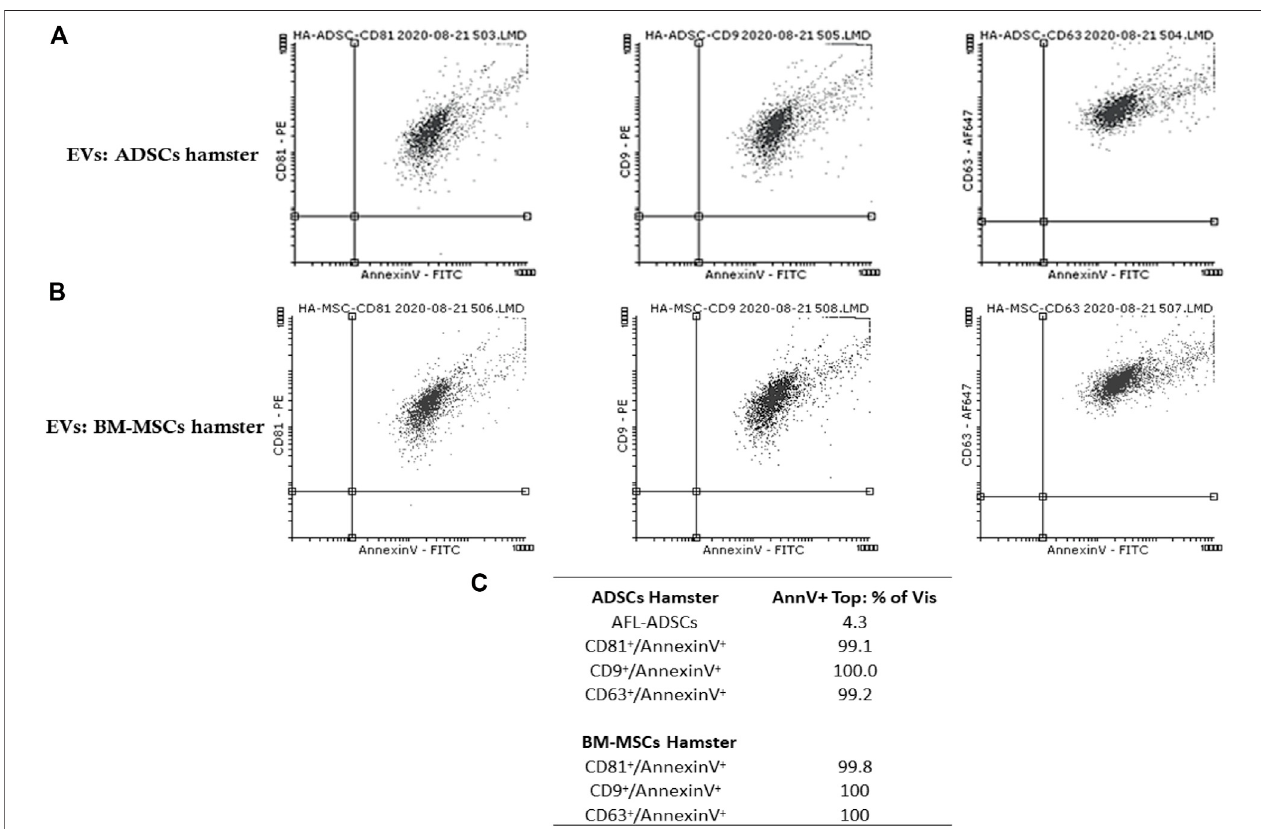
FIGURE 3 | Detection and characterization by fl ow cytometry of EVs isolated from the culture medium from ADSCs/BM-MSCs of healthy hamsters highlight the presence of both exosomes (CD63 + , CD9 + , and CD81 + ) and microvesicles (AnnexinV + ). (A) Representative dot plots double-stained with puri fi ed EVs from ADSC fractionwithCD81 + (labeledwithPE)/AnnexinV + (labeledwithFITC), CD9 + (labeledwithPE)/AnnexinV + (labeledwithFITC),and CD63 + (labeledwithAF647)/Annexin V + (labeled with FITC); (B) representative dot plots double-stained with puri fi ed EVs from the BM-MSC fraction with CD81 + (labeled with PE)/Annexin V + (labeled with FITC), CD9 + (labeled with PE)/Annexin V + (labeled with FITC), and CD63 + (labeled with AF647)/Annexin V + (labeled with FITC) (C) Percentage of EV speci fi c markers for both exosomes and microvesicles.